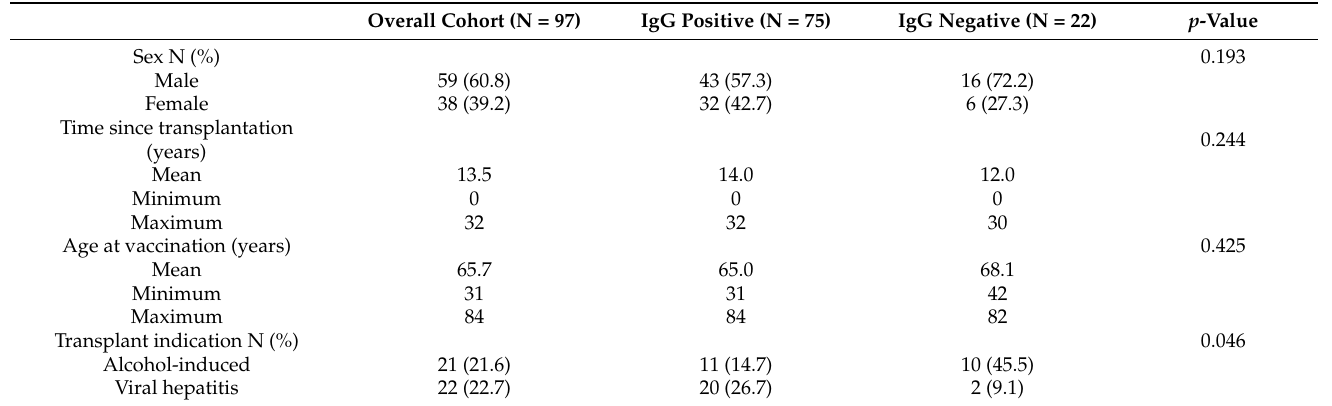
Table A1. Results from outpatient